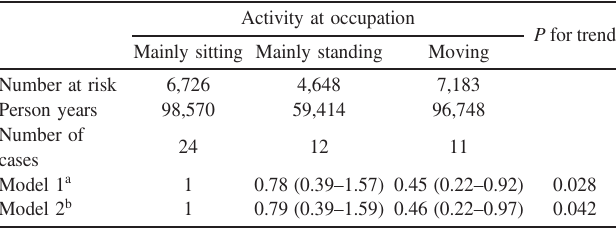
Table 5. Hazard ratios (95% con fi dence intervals) of incident endometrial cancer according to occupational